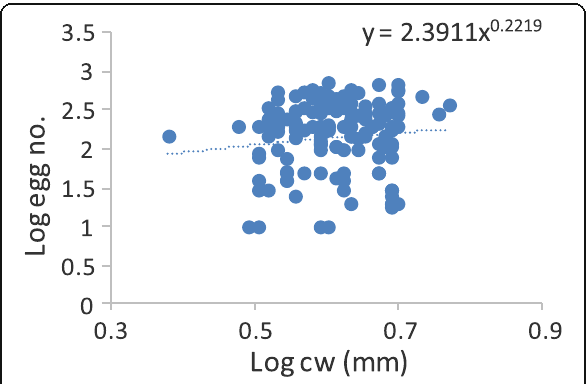
Fig. 7 The logarithmic relationship between carapace width and total egg number of H. marsupials from Gulf of Aqaba, Red Sea,